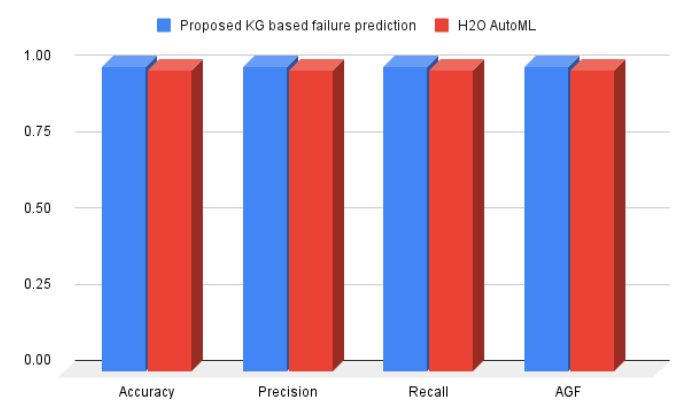
Figure 10. Proposed method versus the state of the art H2O